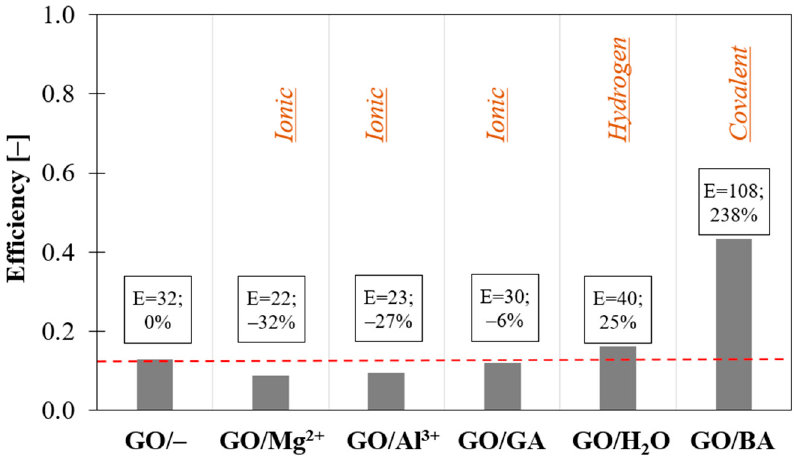
Figure 9. Effect of nanoparticle functionalization on the elastic modulus of GO films without binder.